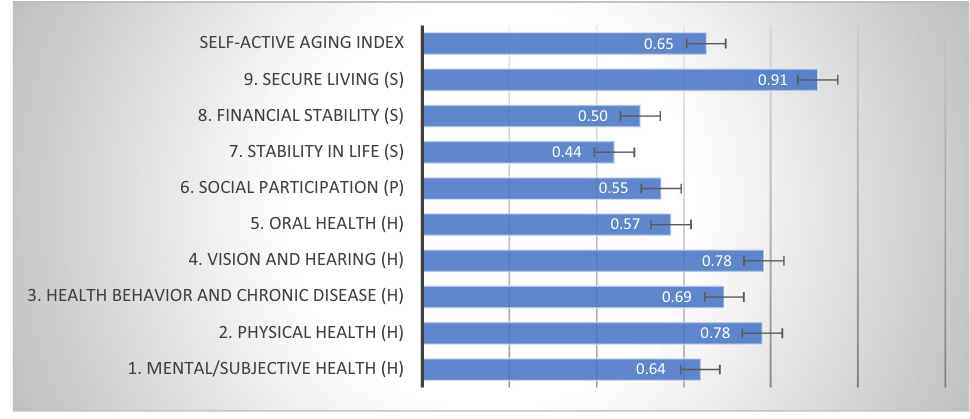
Figure 1. S-AAI scores.